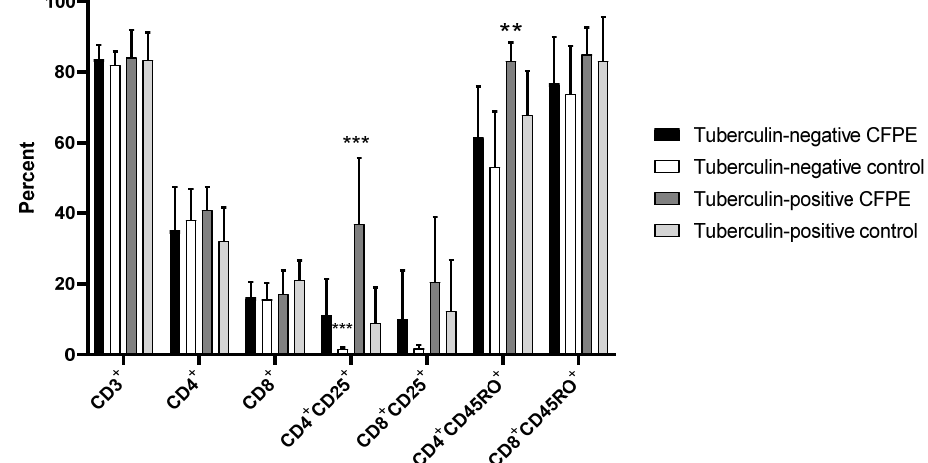
Figure 4. T lymphocyte subpopulations identified with Panel 2 in PBMCs from tuberculin-positive and tuberculin-negative heifers. The cells were cultivated for nine days. ** p < 0.01; *** p < 0.001.